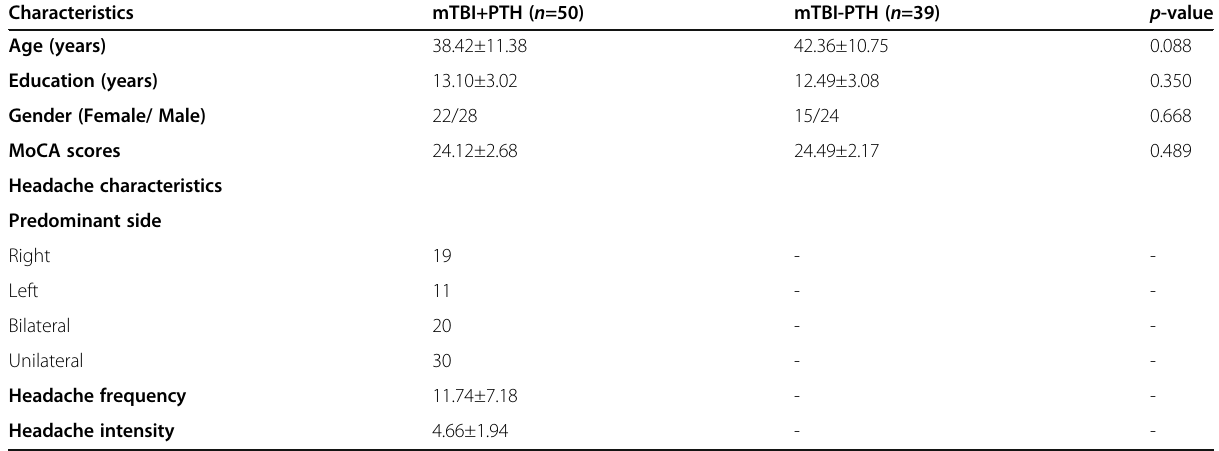
Table 1 Demographic and cognitive variables of the mTBI with PTH patients and mTBI without PTH patients Characteristics